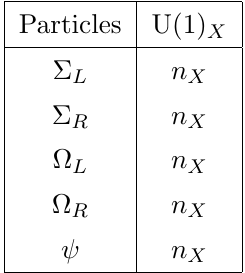
Table 4 . Fields having non-trivial transformation under U(1) X global